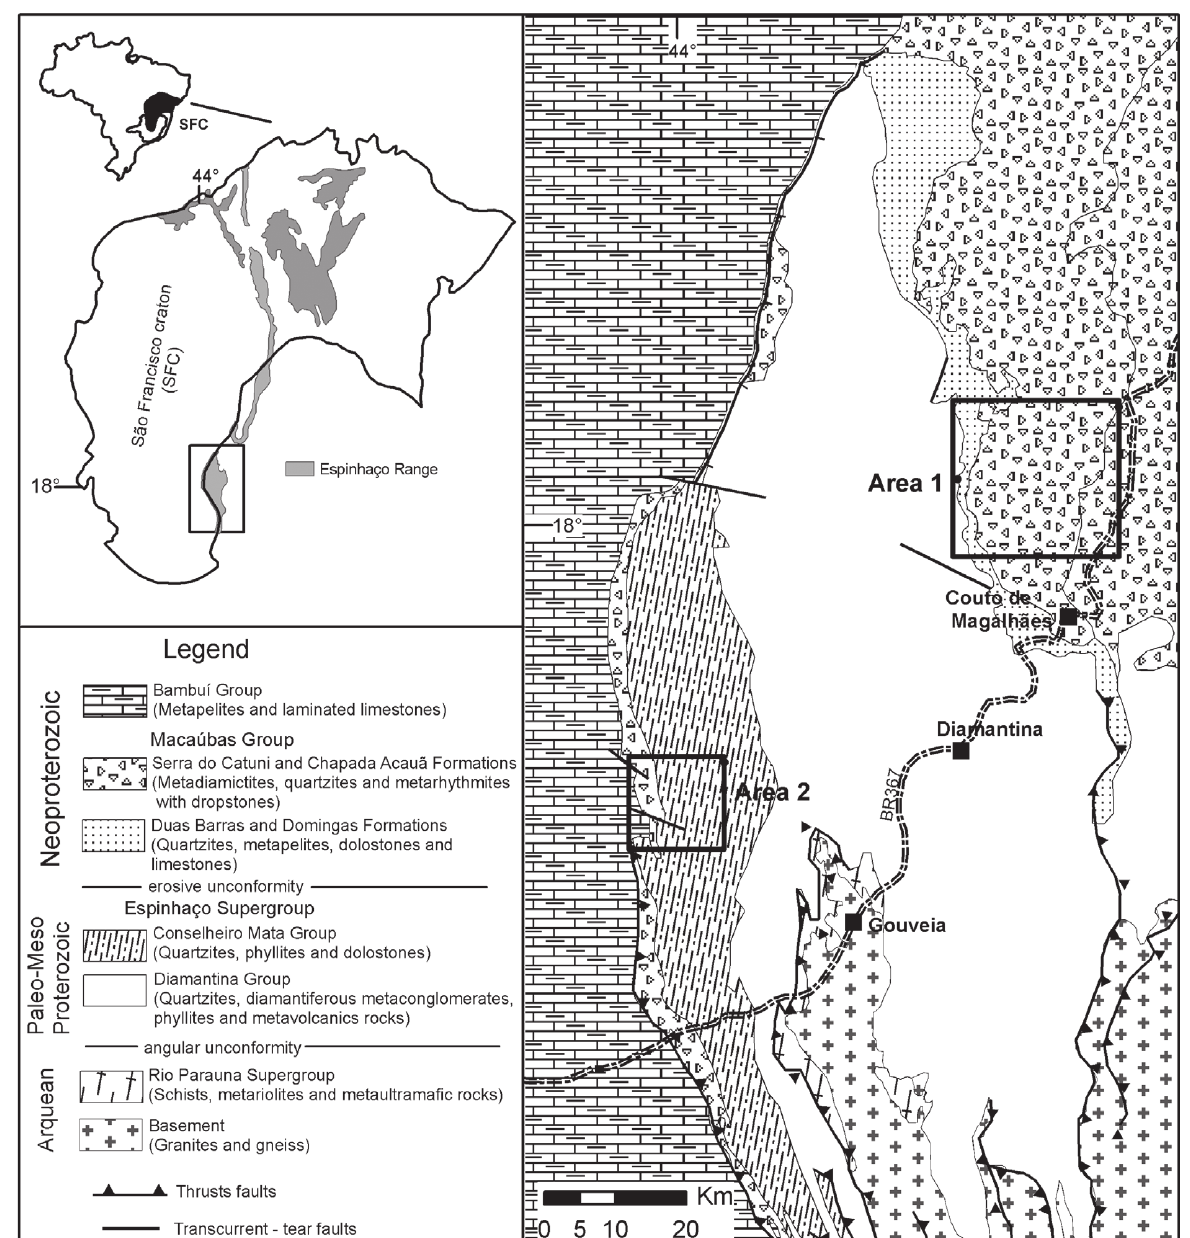
Figure 1 - Location map and simplified geological map of the central region of the Espinhaço Ridge, highlighting the areas studied: Area 1 – Northeast region; Area 2 – western edge (modified from Geological Map of the state of Minas Gerais, 2003 and Almeida